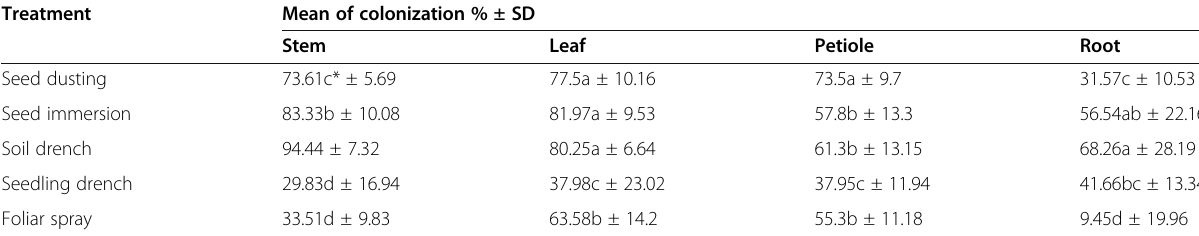
Table 1 Colonization of the fungus, Beauveria bassiana , in cucumber plant under laboratory conditions, 30 days post different inoculation methods